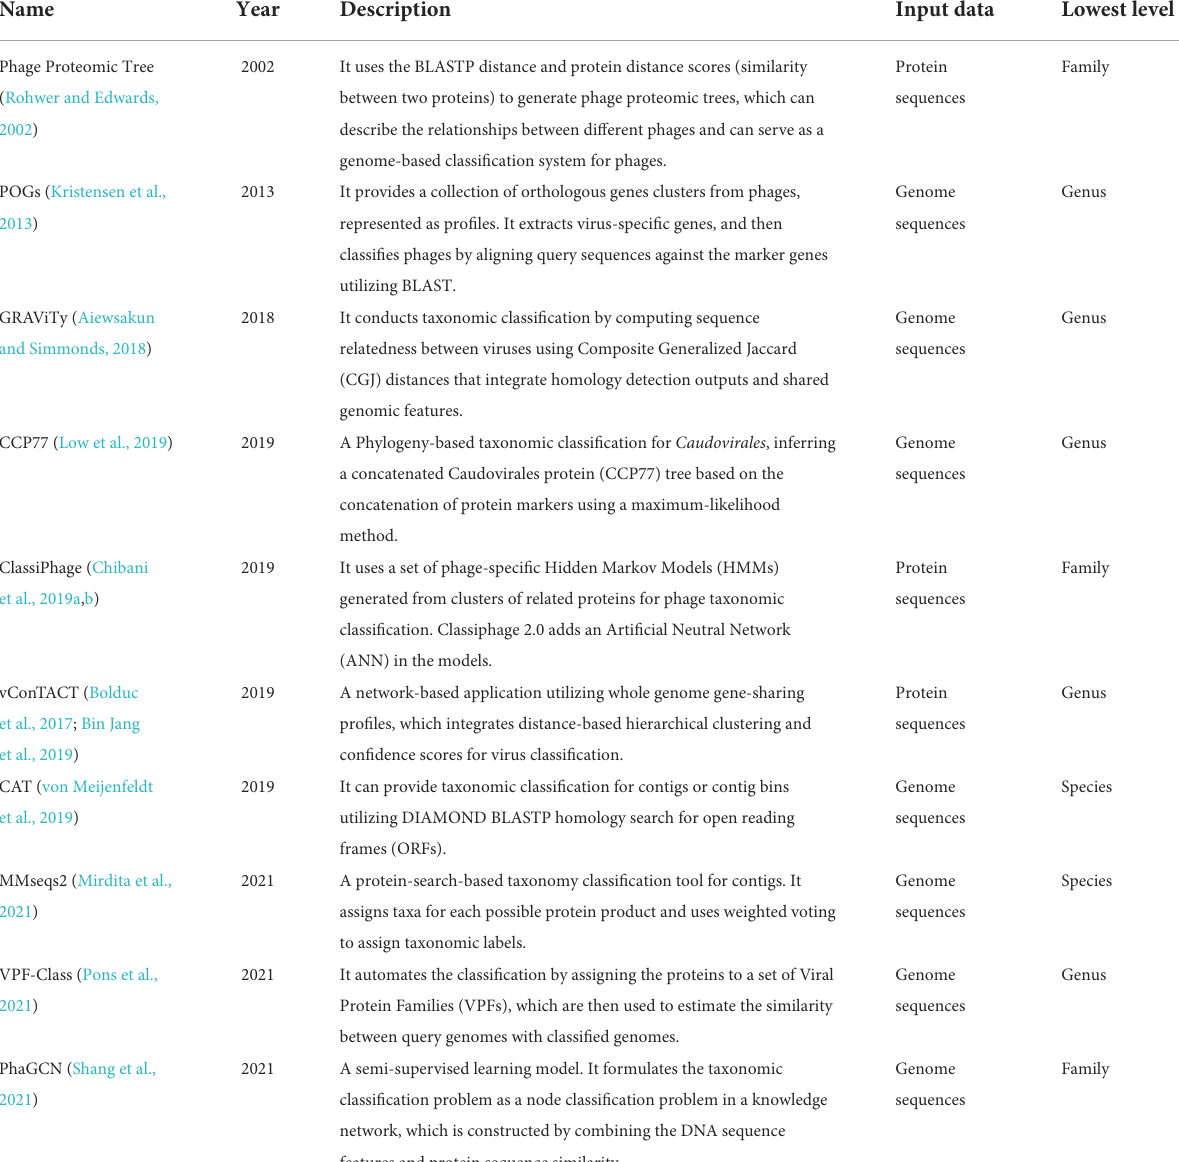
TABLE 2 Overview of bioinformatic approaches used for phage taxonomic